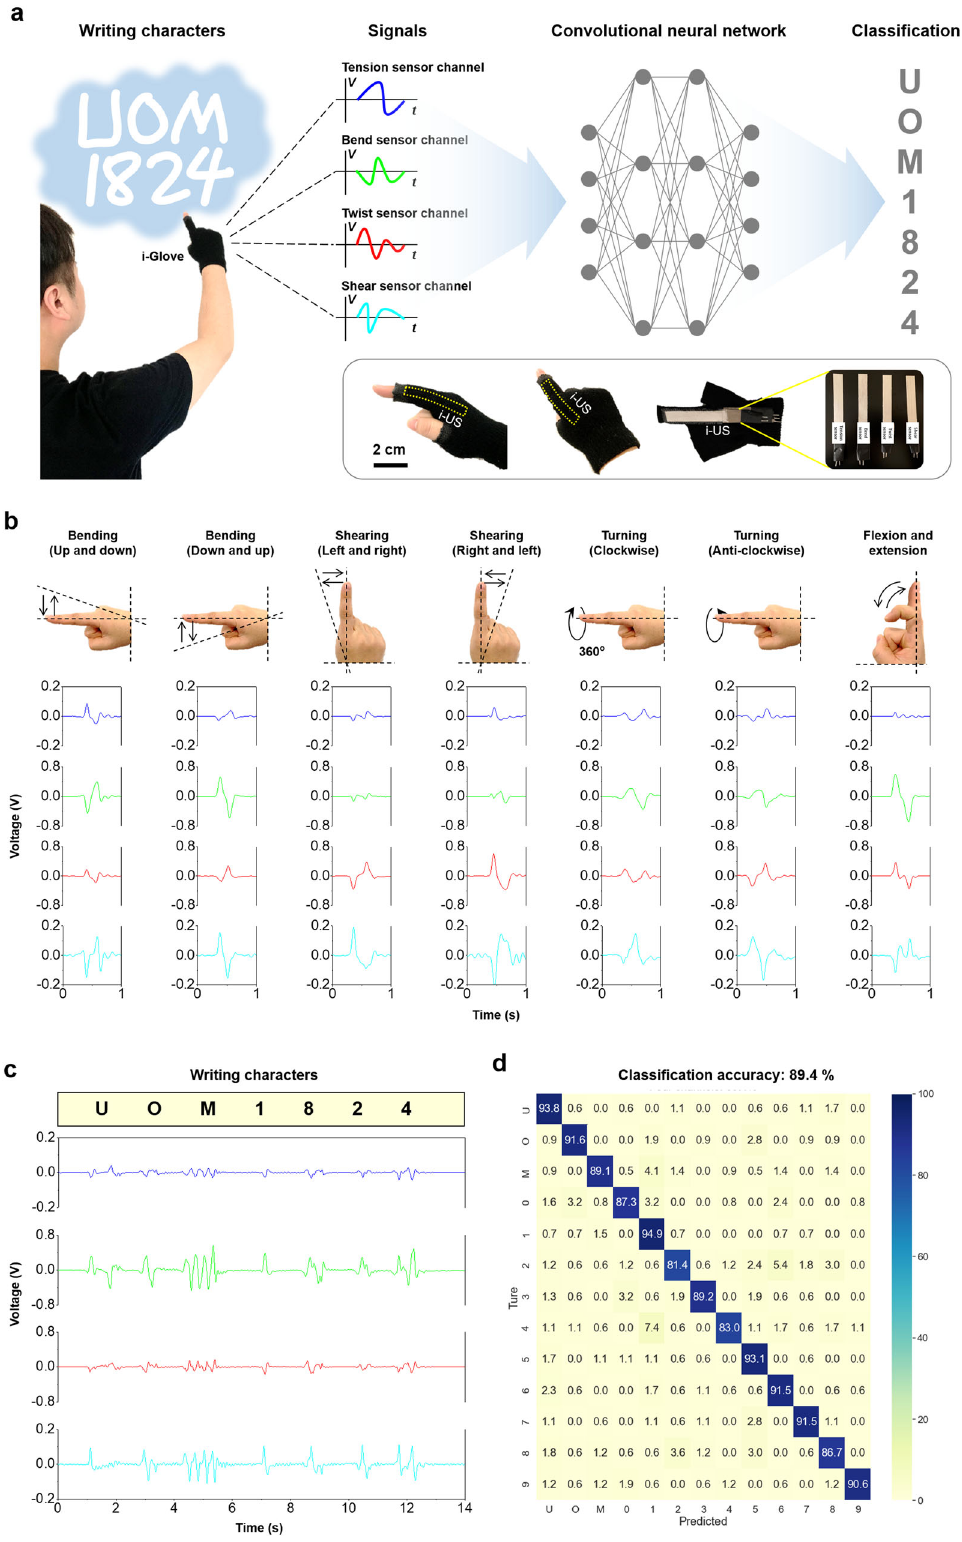
degrees of freedom (e.g., extension/ fl exion, radial/ulnar deviation, pronation/supination) as shown in Supplementary Fig. 12 and Supplementary Video 4. More importantly, a complicated wrist turning action comprising three bending, twisting, and